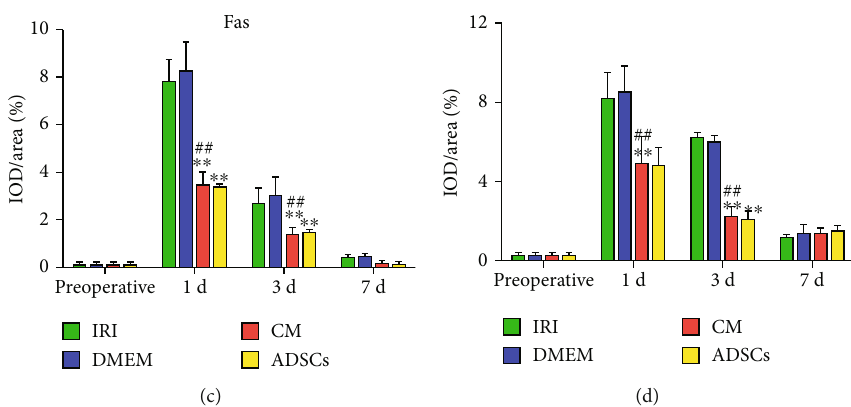
Figure 5: In situ expression levels of Fas and Fasl protein in liver tissues. (a, b) Representative images of immunohistochemically stained Fas and Fasl protein in the indicated groups (magni fi cation 400x). (c, d) Relative expression levels of Fas and Fasl. ∗ P < 0 : 05 and ∗∗ P < 0 : 01 compared to IRI group; # P < 0 : 05 and ## P < 0 : 01 compared to DMEM